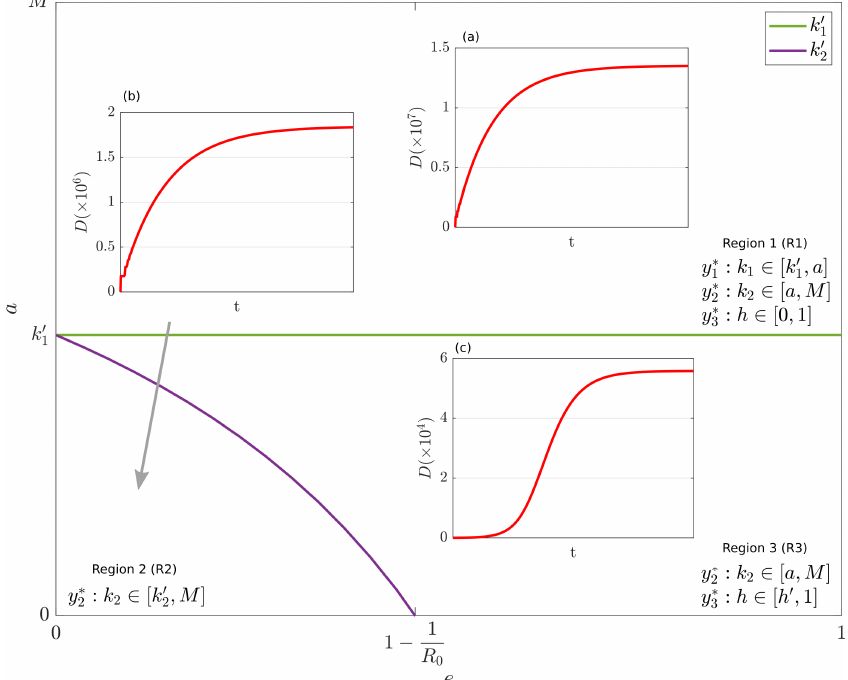
Figure 2. Graphical representation of the statements of Propositions 1–3. The insets display the dynamics of D in each of the three regions. Inset ( a ): e = 0.2 and a = 1.4 · 10 7 . Inset ( b ): e = 0.2 and a = 10 3 . Inset ( c ): e = 0.24 and a = 10 3 . For all the simulations, the other parameters have been set as follows: β 0 = 0.35, γ = 0.07, τ = 0.2, ω = 0.04, ζ = 0.002, α = 3 · 10 − 4 , σ 0 M = 60 · 10 6 , U ( 0 ) = 100 and x ( 0 ) =